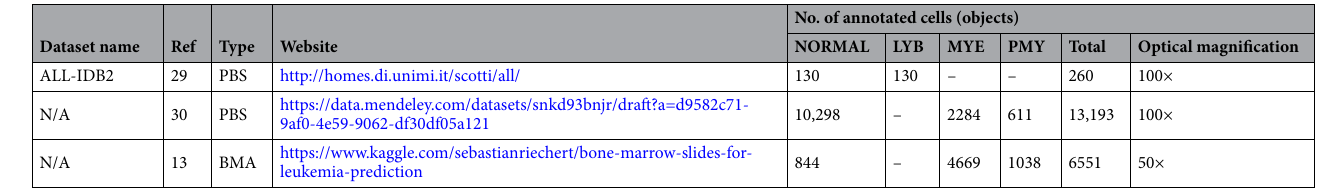
Table 2. Image datasets with single cell (object-level) annotations used to validate MILLIE. PBS peripheral blood film, BMA bone marrow aspirate, LYB lymphoblasts, MYE myeloid lineage cells, PMY